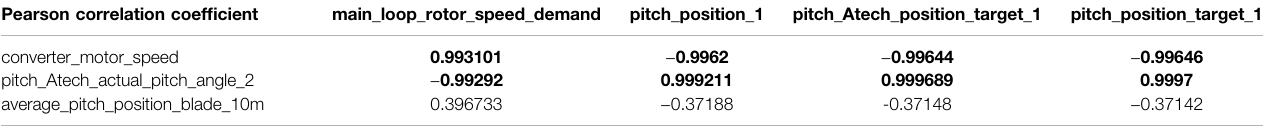
TABLE 3 | Correlation results between the features. Pearson correlation coef fi cient